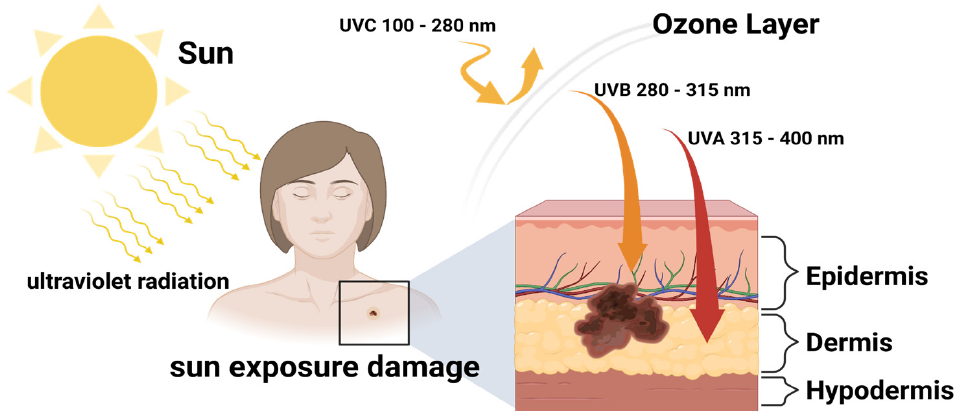
Figure 4. UV light damage to the skin. UV radiation is composed of UVA and UVB rays, and has the ability to penetrate the skin layers. Various UV rays will have different impacts and effects on the skin; UVA and UVB rays are mainly linked to long-term skin damage and play a key role in some skin cancers [42]. Created with BioRender.com.